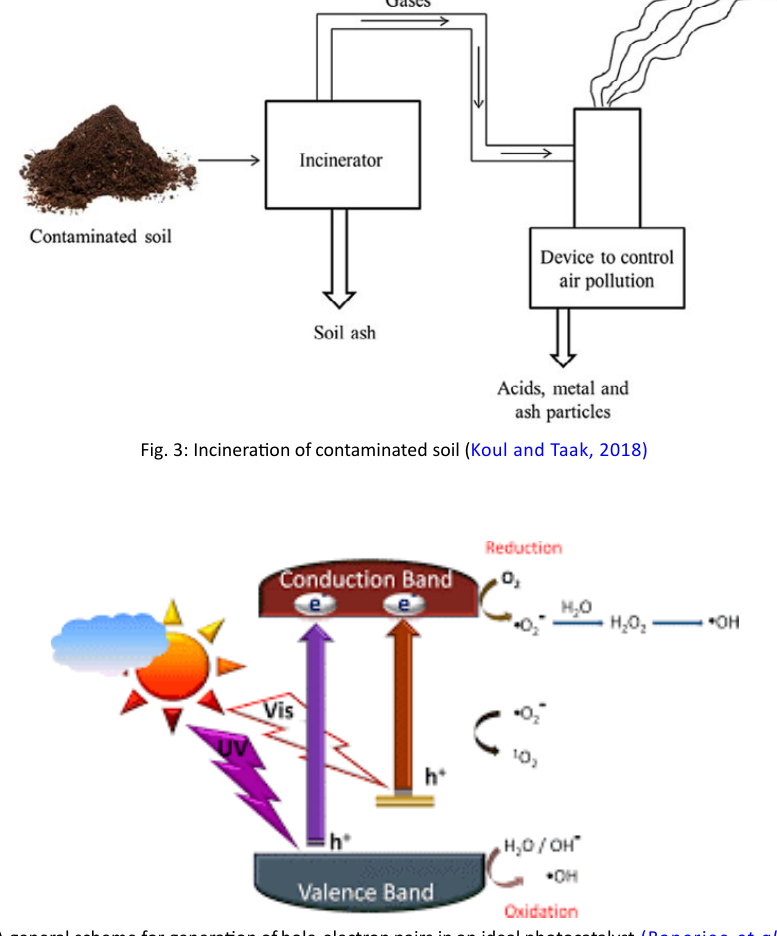
Fig. 4: A general scheme for generation of hole-electron pairs in an ideal photocatalyst (Banerjee et al ., 2014)